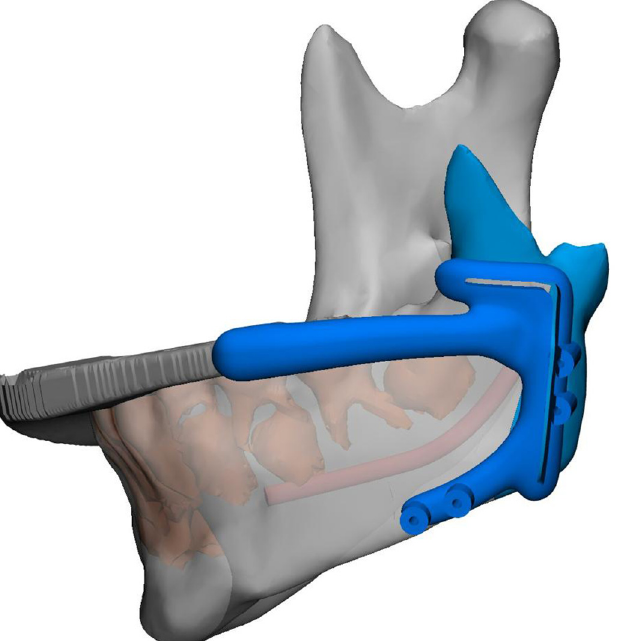
Fig. 4. Virtual planning of the osteotomy guide and installation of the distractor.